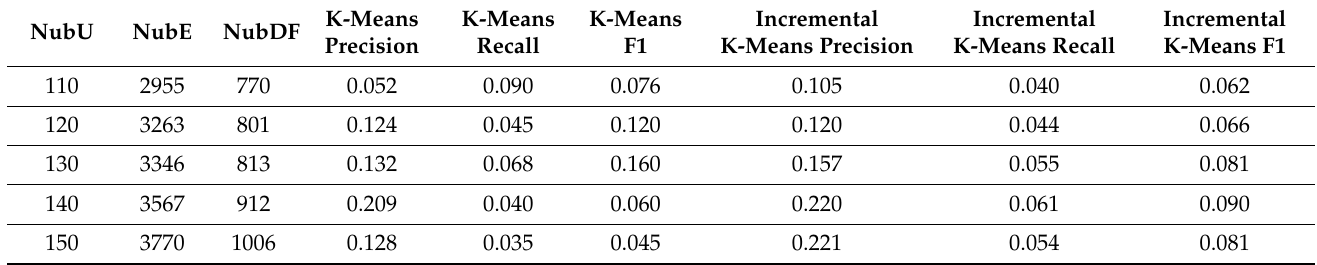
Table 2. Outcomes of K-means and incremental K-means algorithms with social information.